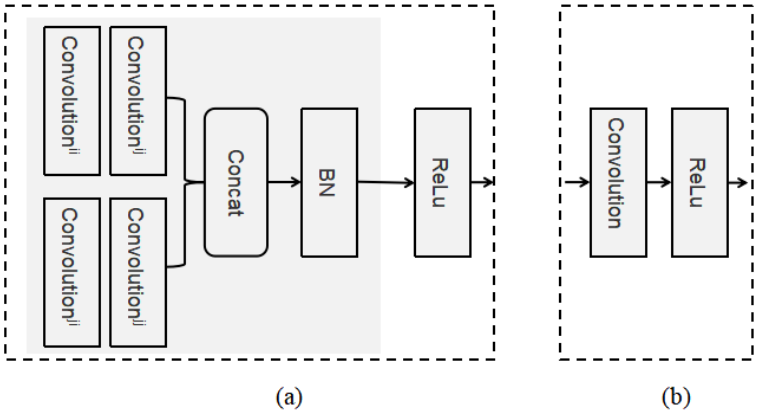
Figure 3. Convolution block. ( a ) Convolution block used in this paper. ( b ) Original convolution block.